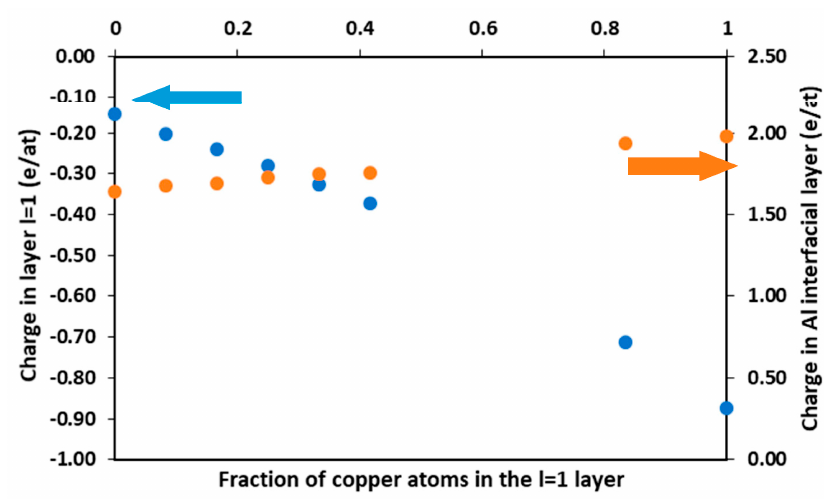
Figure 4. Evolution of the average electron charge per atom in the interfacial Al layer (orange, right y axis) and the layer l = 1 (blue, left y axis) depending on the copper fraction in the metallic layer l = 1.